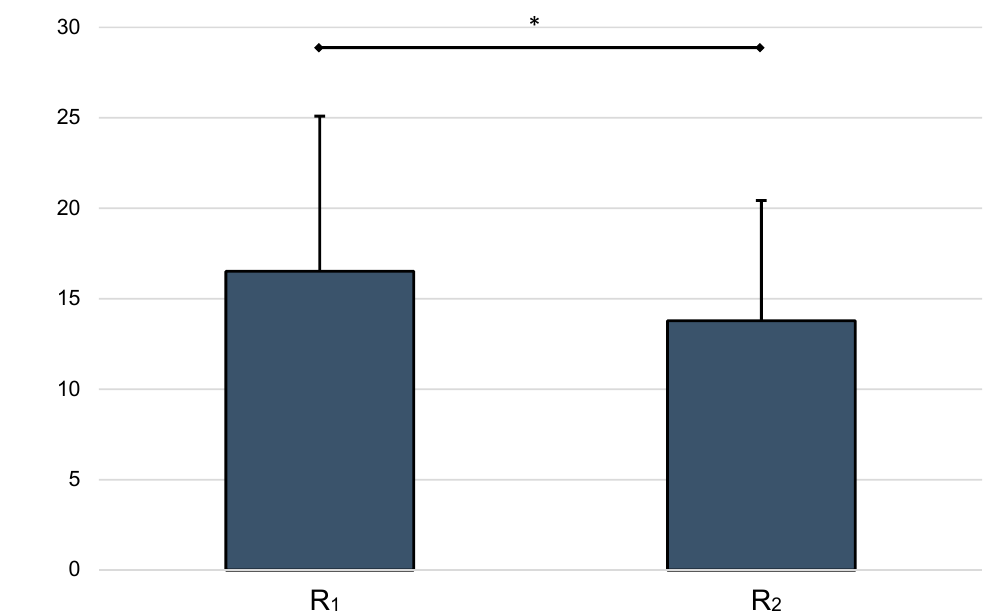
Figure 6. Mean HU values, analyzed by height. Whiskers represent standard deviations. Significant differences (* p < 0.05) are designated by asterisks.